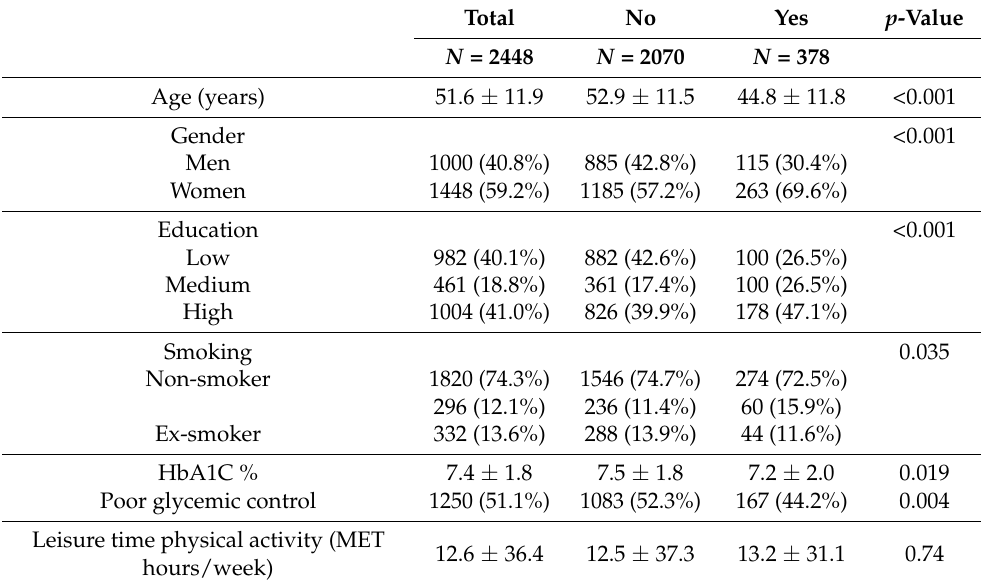
Table 1. Sample characteristics by presence pf depressive